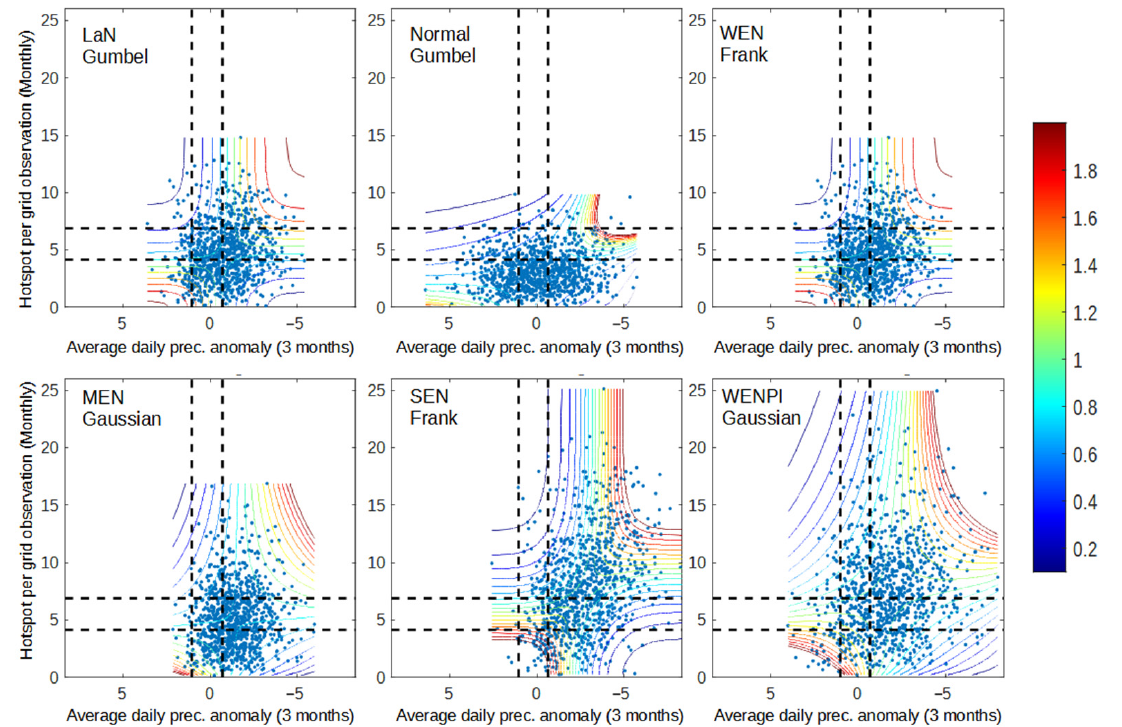
Figure 4. Dependency graph of precipitation anomaly and hotspot for 2001–2020 data. The dashed lines represent the separation of wet ( bottom / left ), normal ( middle ), and dry ( up / right ) conditions for precipitation anomaly (vertical line) and hotspot (horizontal line).